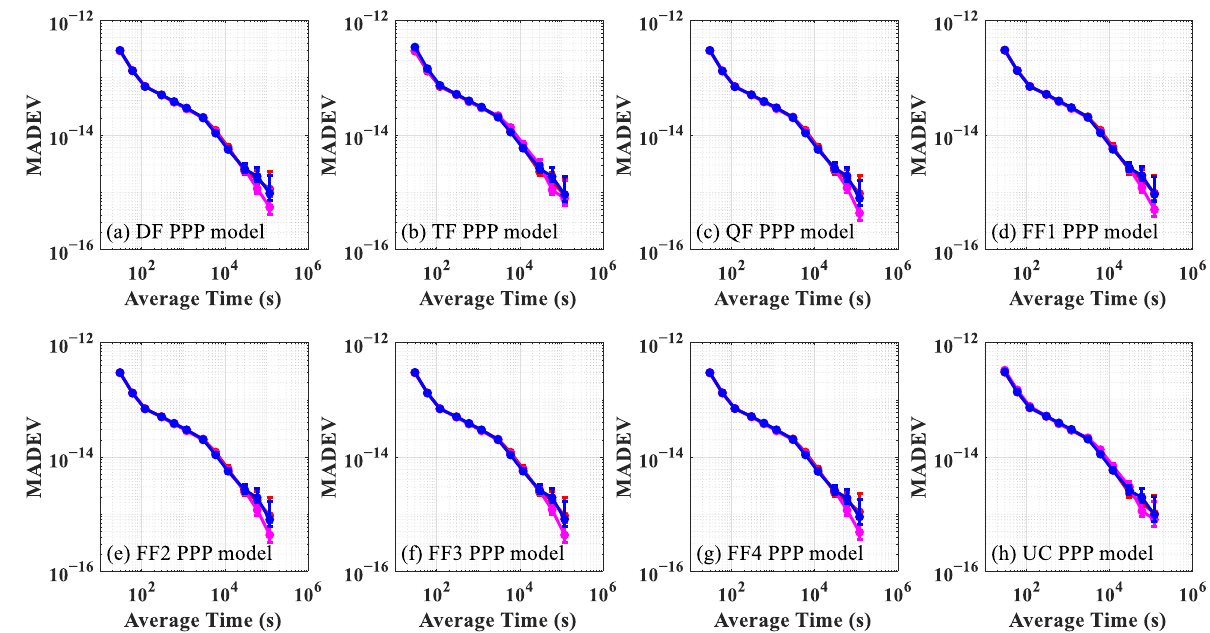
Figure 15. MADEV at the BRUX-USN7 time-frequency link of the PPP solution by using GBM, WUM and GRG precision products on DOYs 190 to 196 in 2020. ( a ) DF PPP model; ( b ) TF PPP model; ( c ) QF PPP model; ( d ) FF1 PPP model; and ( e ) FF2 PPP model; ( f ) FF3 PPP model; ( g ) FF4 PPP model; ( h ) UC PPP model.